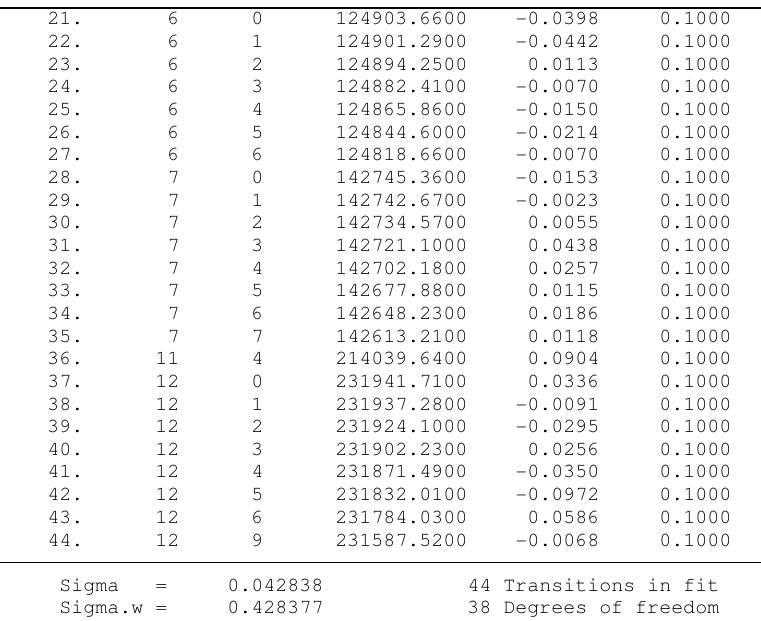
CN, CH 313 CN and CH 3